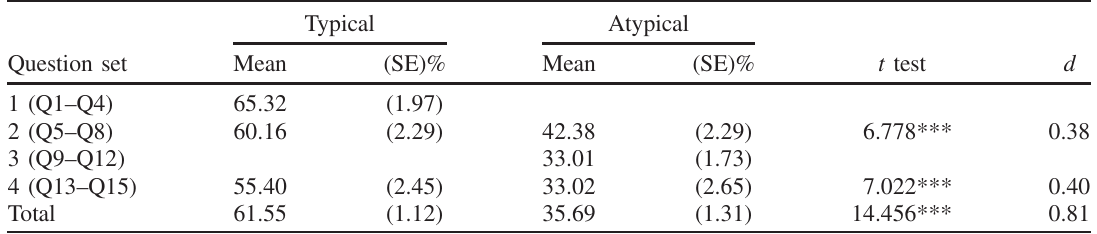
TABLE II. Typical and atypical scores in each question set and statistical significance of differences. Typical